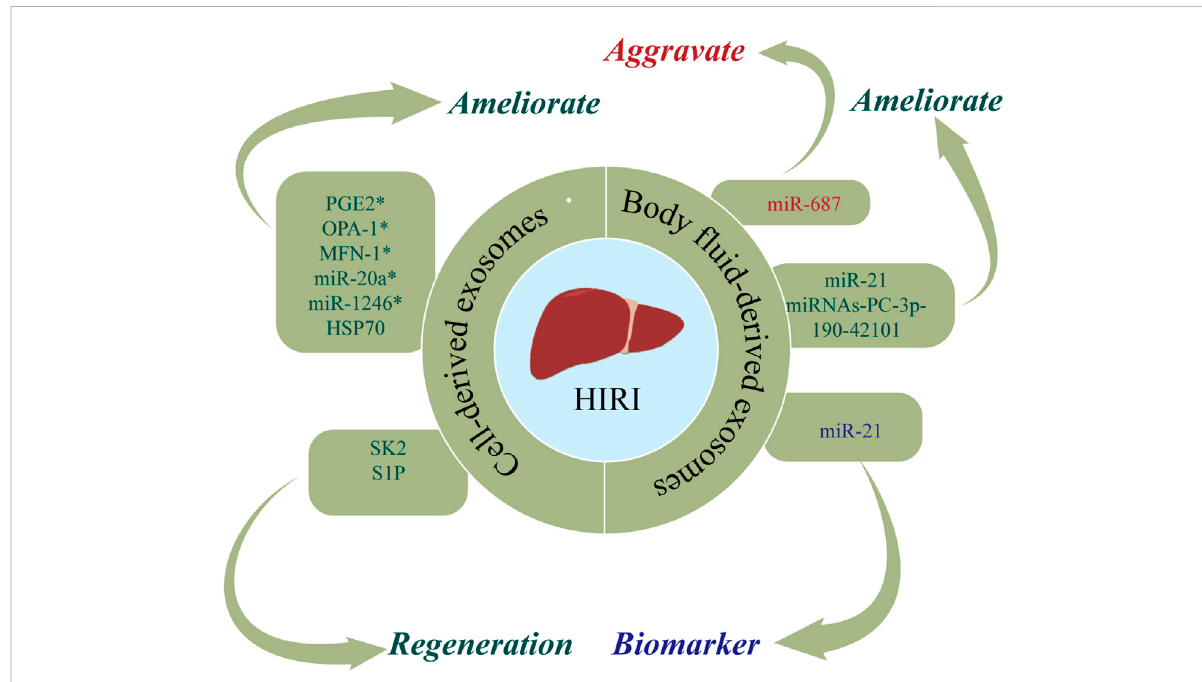
FIGURE 3 The roles of nucleic acids and proteins carried by exosomes in hepatic ischemia reperfusion injury (HIRI). Nucleic acids or proteins that may aggravate HIRI are highlighted in red, ameliorating HIRI are highlighted in green, and biomarkers are highlighted in purple. * refers to nucleic acids and proteins carried by exosomes from mesenchymal stem cell.